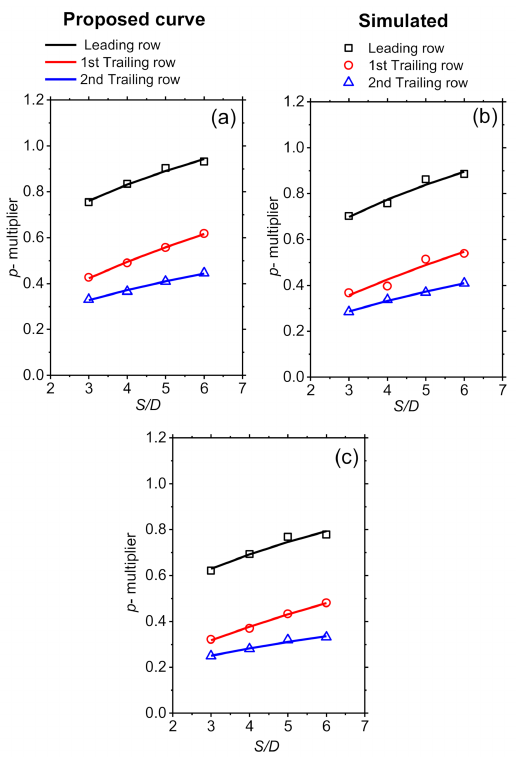
Figure 6. Regression between calculated p -multipliers vs. S/D for various rows for fixed-head condition: ( a ) ϕ = 30 ◦ , ( b ) ϕ = 35 ◦ , and ( c ) ϕ = 40 ◦